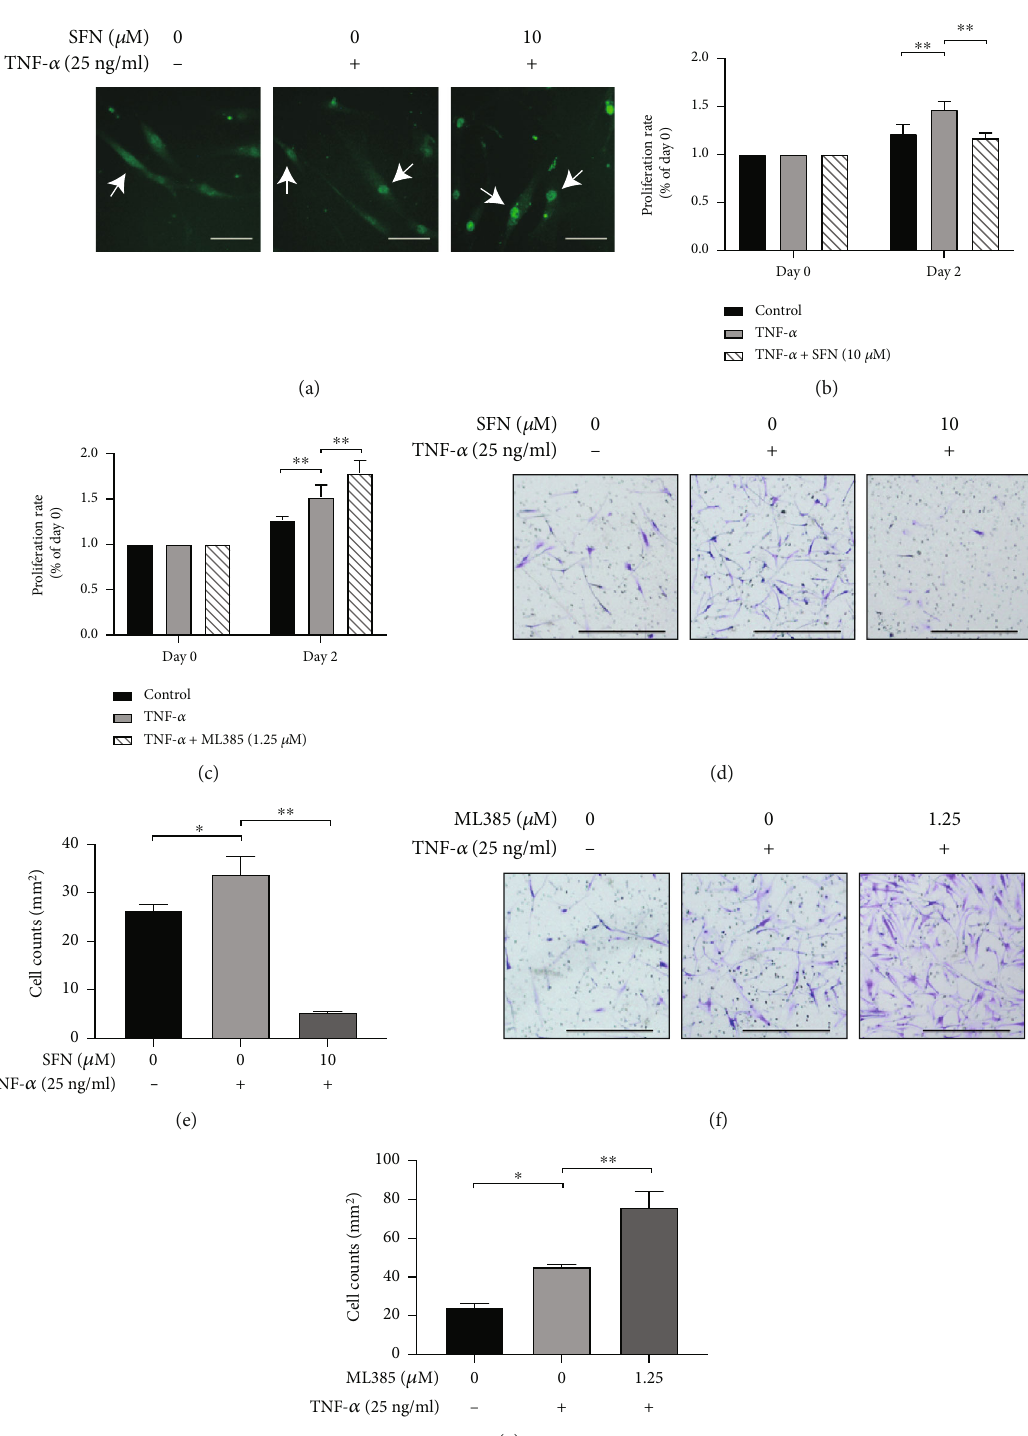
Figure 4: E ff ects of nrf2 activator and inhibitor on proliferation and invasion of RA-FLS. (a) Nrf2 nuclear translocation (as shown by white arrows) was tested with immuno fl uorescence staining in RA-FLS after pretreatment with nrf2 activator sulforaphane (SFN) at a concentration of 10 μ M for 1 h and subsequently stimulating with/without TNF- α (25 ng/mL) for 3h. (b, c) Proliferation of RA-FLS treated with SFN or ML385 was analyzed by CCK-8 assay. Cells seeded in the 96-well plate were pretreated with SFN (10 μ M) (b) or ML385 (1.25 μ M) (c) for 1h and subsequently stimulated with/without TNF- α (25 ng/mL) for 2 days. (d – g) Invasion analysis of RA-FLS treated by SFN or ML385 was performed with transwell assay. Cells seeded in the transwell chamber were pretreated with SFN (10 μ M) (d, e) or ML385 (1.25 μ M) (f, g) for 1 h and subsequently stimulated with/without TNF- α (25 ng/mL) for 2 days. Scale bar represented 200 μ m. N = 3 . Data were shown as the mean ± SD ; ∗ p < 0 : 05 and ∗∗ p < 0 : 01